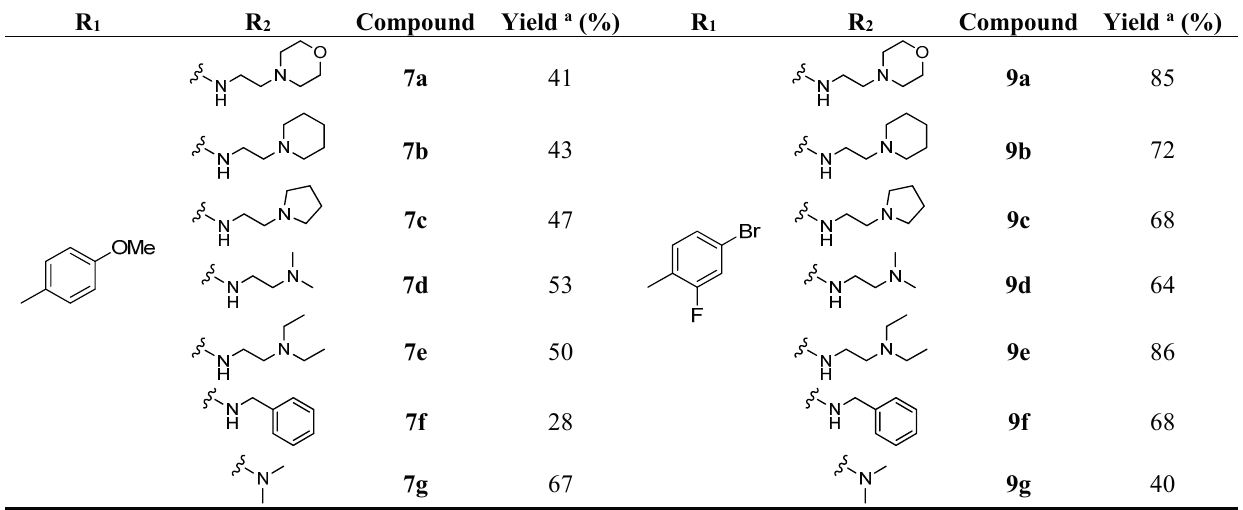
Table 1. Chemical structures and yields obtained for the synthesis of the four series ( 7a – g – 10a – g ). R 1 R